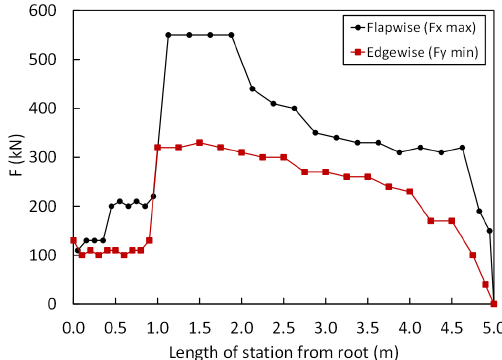
Figure 8. Extreme external load distribution along span length.